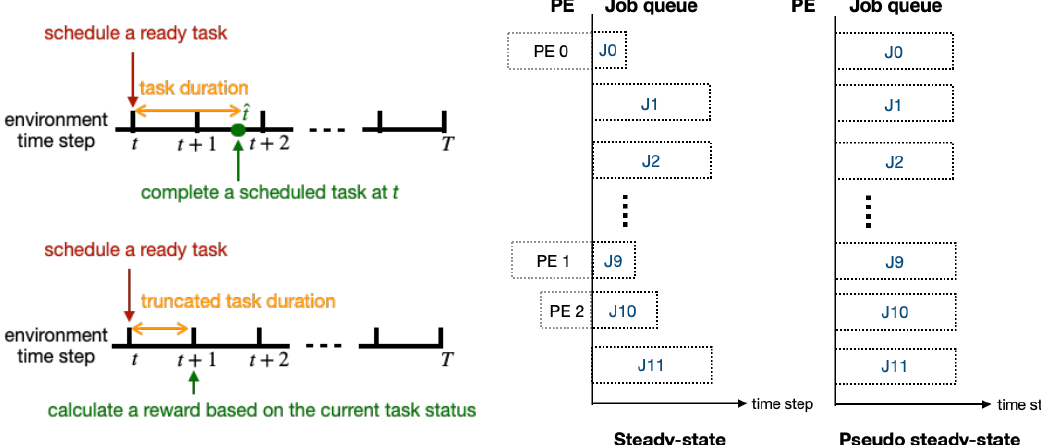
Figure 6. Left panel a timeline for the agent-environment interaction. The top figure illustrates that the reward is received after the scheduled task is completed. We emphasize that the previously scheduled task has not completed yet, but the agent receives the next state because any task with no predecessor can arrive in the task queue. Also, the number of rewards depends on the number of actions. Thereby, the agent transitions cannot be stored in a sequential order, ( s 1 , a 1 , r 1 , s 2 ,..., s T ) . This violates the standard MDP assumption. The bottom figure truncates the reward sequence in between the scheduling time step so that the agent receives the reward based on the onward task duration. In this case, the computing reward approximates the true reward value, but the agent time step and environment time step become consistent. The right figure shows a standard steady-state, which is when all jobs are stacked to the job queue and a pseudo-steady-state, which approximates the steady-state. In a pseudo-steady-state, all jobs are stacked to the job queue without capturing previous decisions. This disregards the past decisions but having a non-empty job